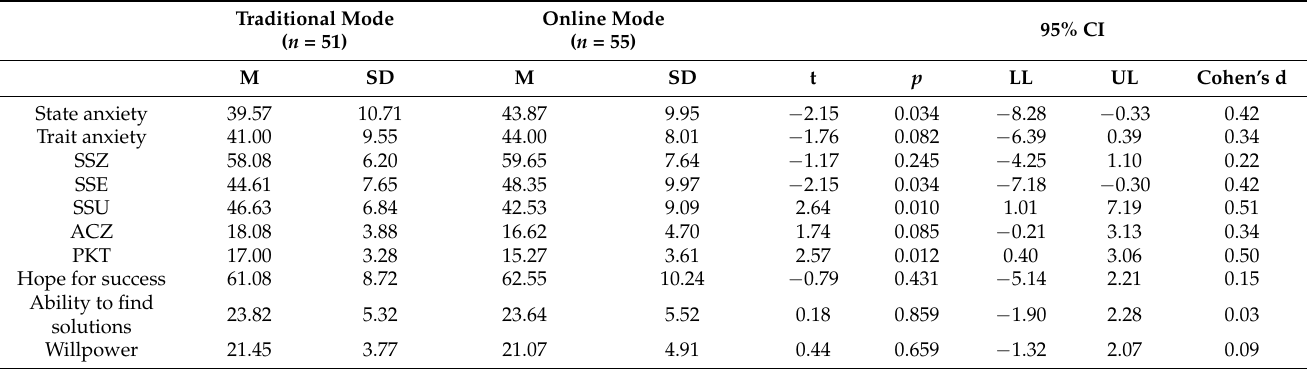
Table 2. Comparison of anxiety levels, coping styles, and hope for success among graduate students due to the exam